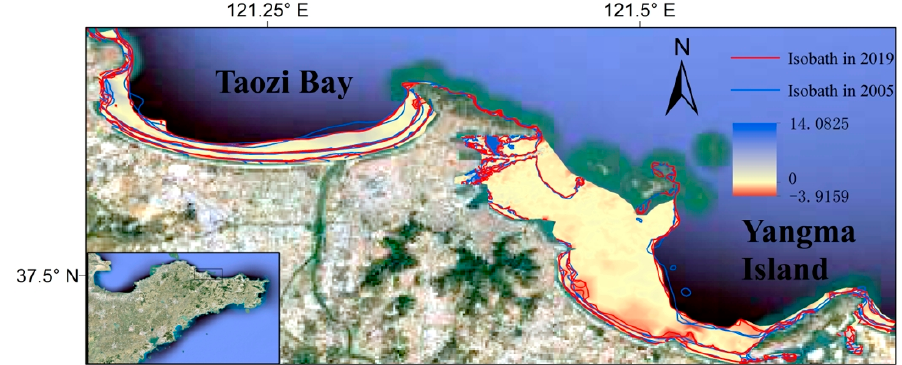
Figure 10. Isobaths and scouring–siltation changes between Taozi Bay and Yangma Island.